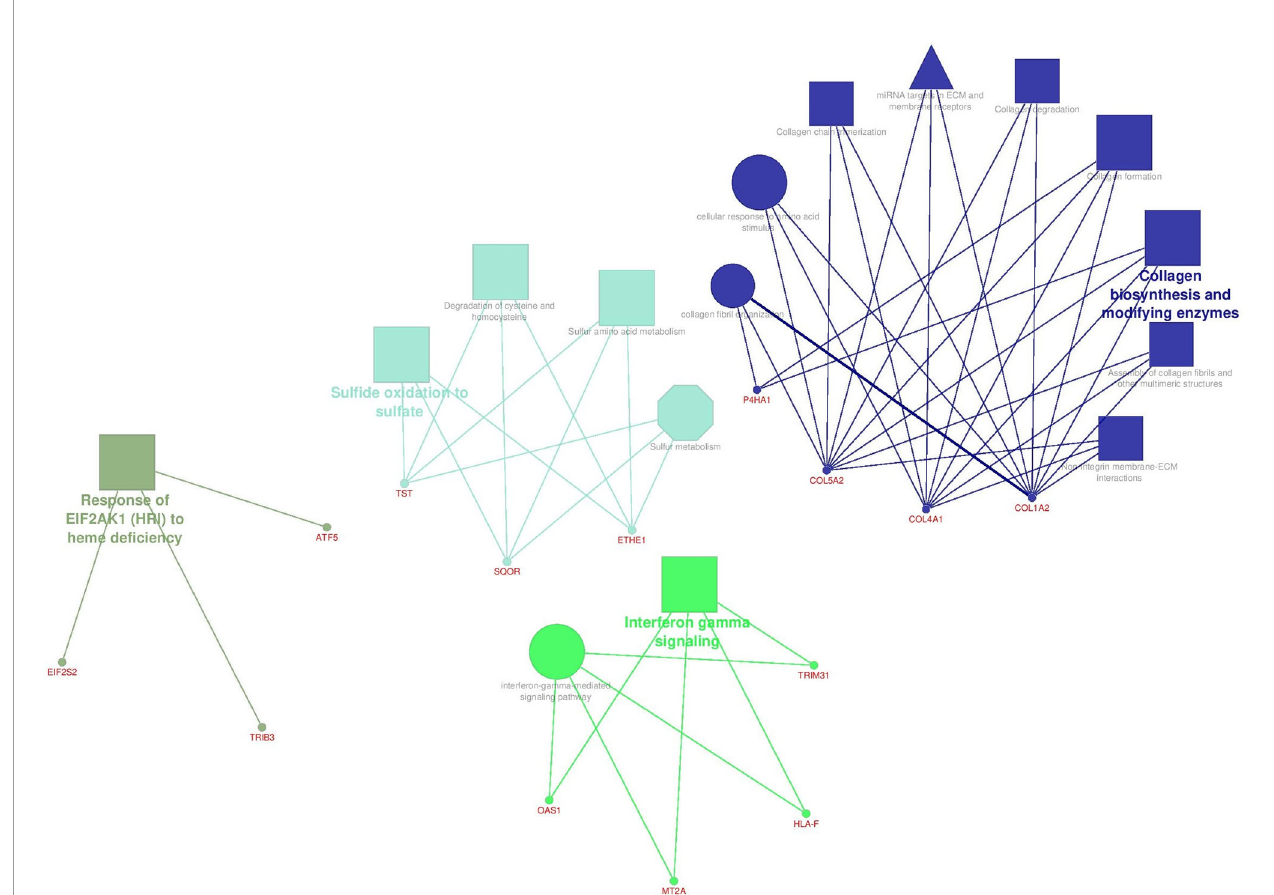
FIGURE 6 | The enrichment results for the Core network genes. Terms in the shape of octagons are from KEGG, Triangular terms are from WikiPathways, rectangular expressions are from Reactome and circular terms are from GO database. Size of the terms present their signi fi